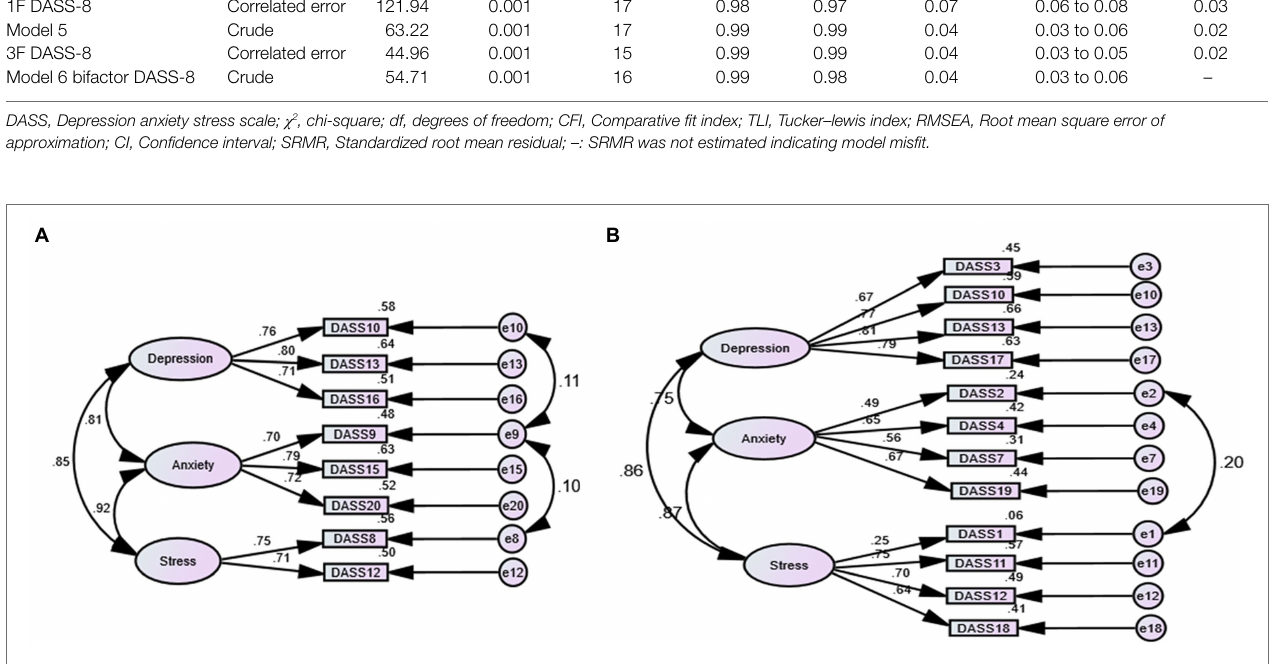
FIGURE 1 | Three-factor structure of shortened versions of the Depression Anxiety stress scale (DASS) 21 in healthy participants, in order: the DASS-8 (A) and the DASS-12 (B)